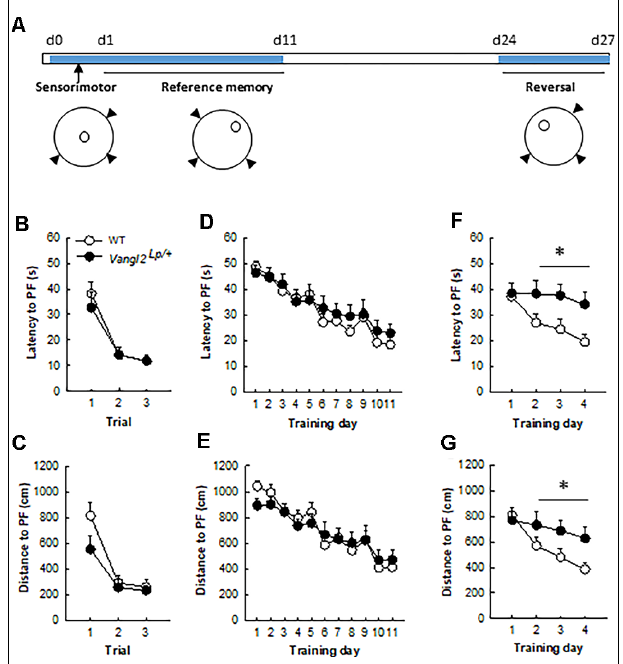
FIGURE 2 | Vangl2 lp mutation leads to deficits in memory flexibility in 4-month-old mice. (A) Timeline of the experiment. (B) Latency to find a cued platform. (C) Distance to find a cued platform. (D) Latency to find a hidden platform in a reference memory protocol. (E) Distance to find a hidden platform in a reference memory protocol. (F) Latency to find a hidden platform in a reversal protocol. (G) Distance to find a hidden platform in a reversal protocol. White dots, WT n = 20 mice; Black dots, Vangl2 Lp/+ n = 12 mice. ∗ p < 0.05.